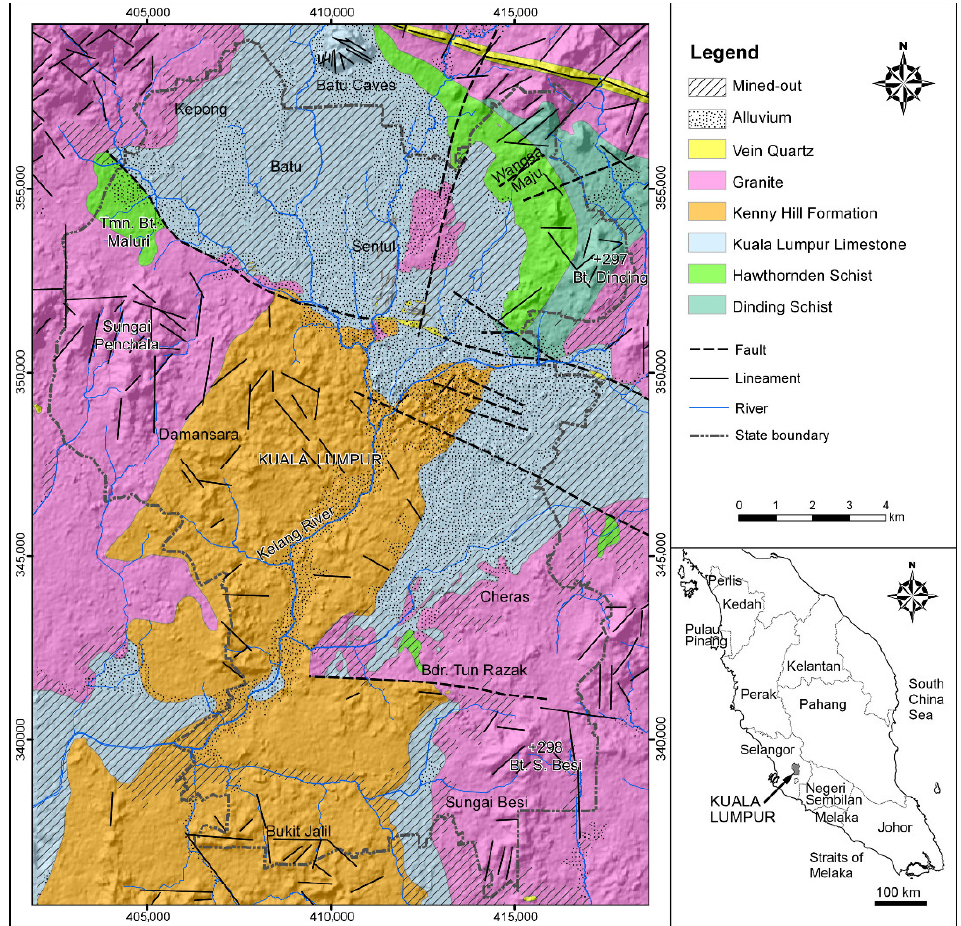
Figure 1. Geological map of the Kuala Lumpur area. The city of Kuala Lumpur is located within the Selangor state, in central-west Peninsular Malaysia.